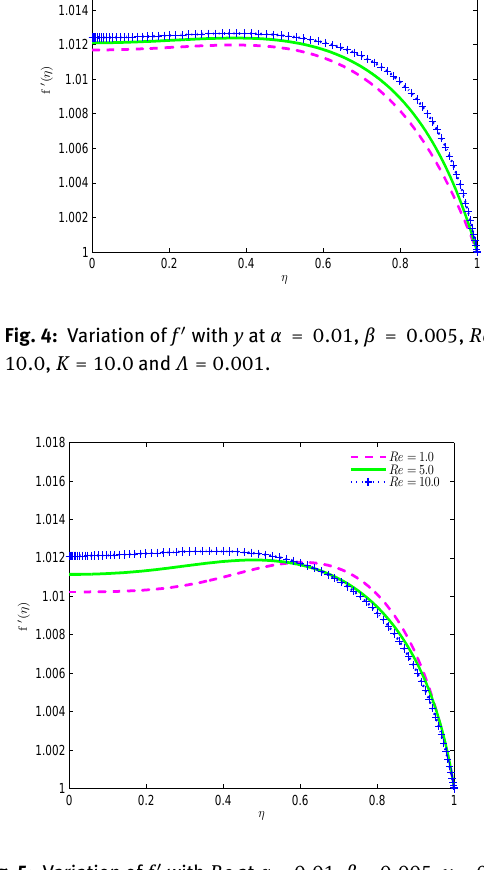
Fig. 5: Variation of f (cid:48) with Re at α = 0.01 , β = 0.005 , γ = 0.01 , K = 10.0 and Λ = 0.001 .